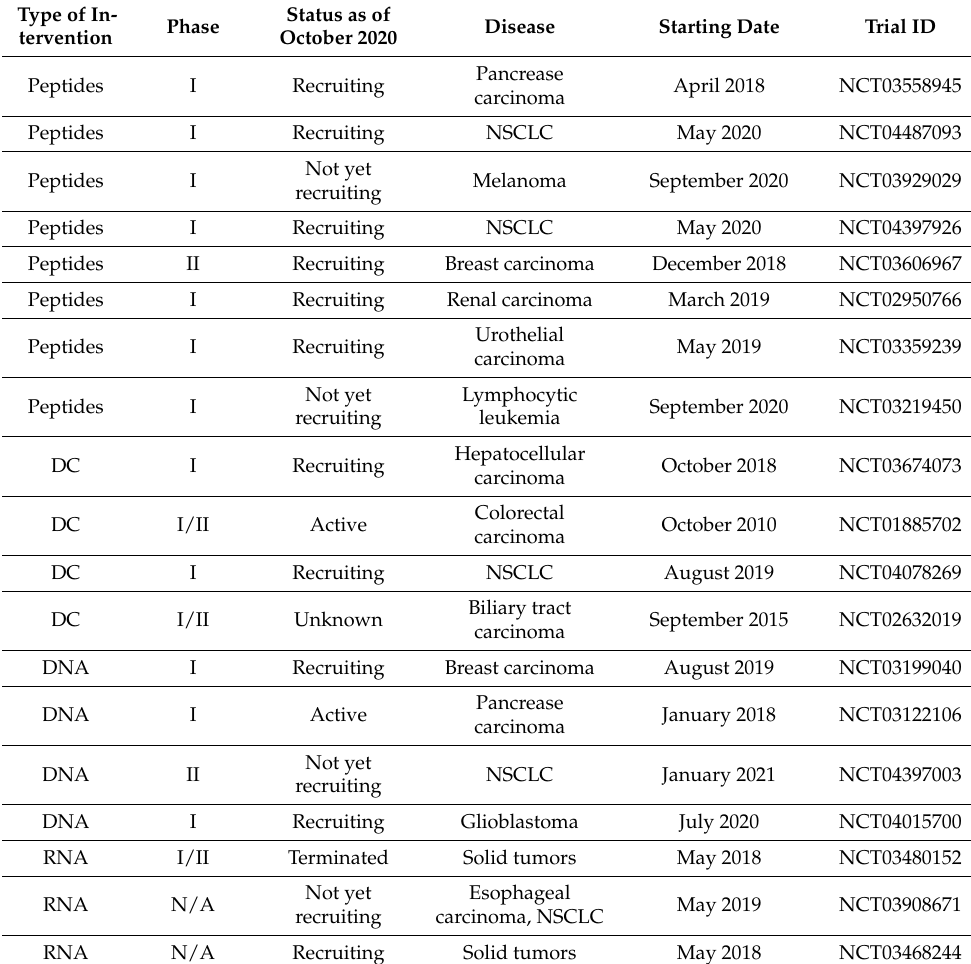
Table 1. Clinical trials of neoantigen-encoded cancer